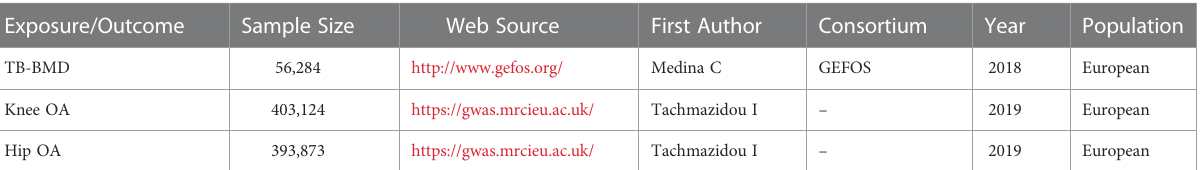
TABLE 1 Details of Studies and Datasets Used in the Study.